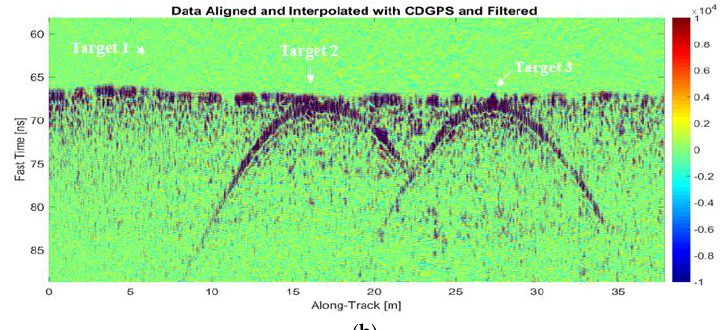
Figure 10. Processed radargram Test 1-Track 2: ( a ) aligned ad interpolated radargram by exploiting GPS information and after filtering operations; ( b ) aligned and interpolated radargram by exploiting CDGPS information and after filtering operations.